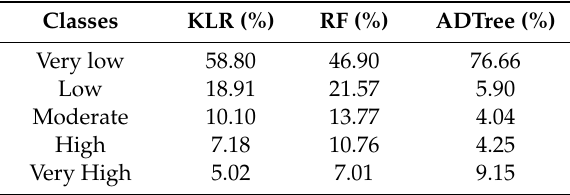
Table 4. Percentages of groundwater spring-potential classes.